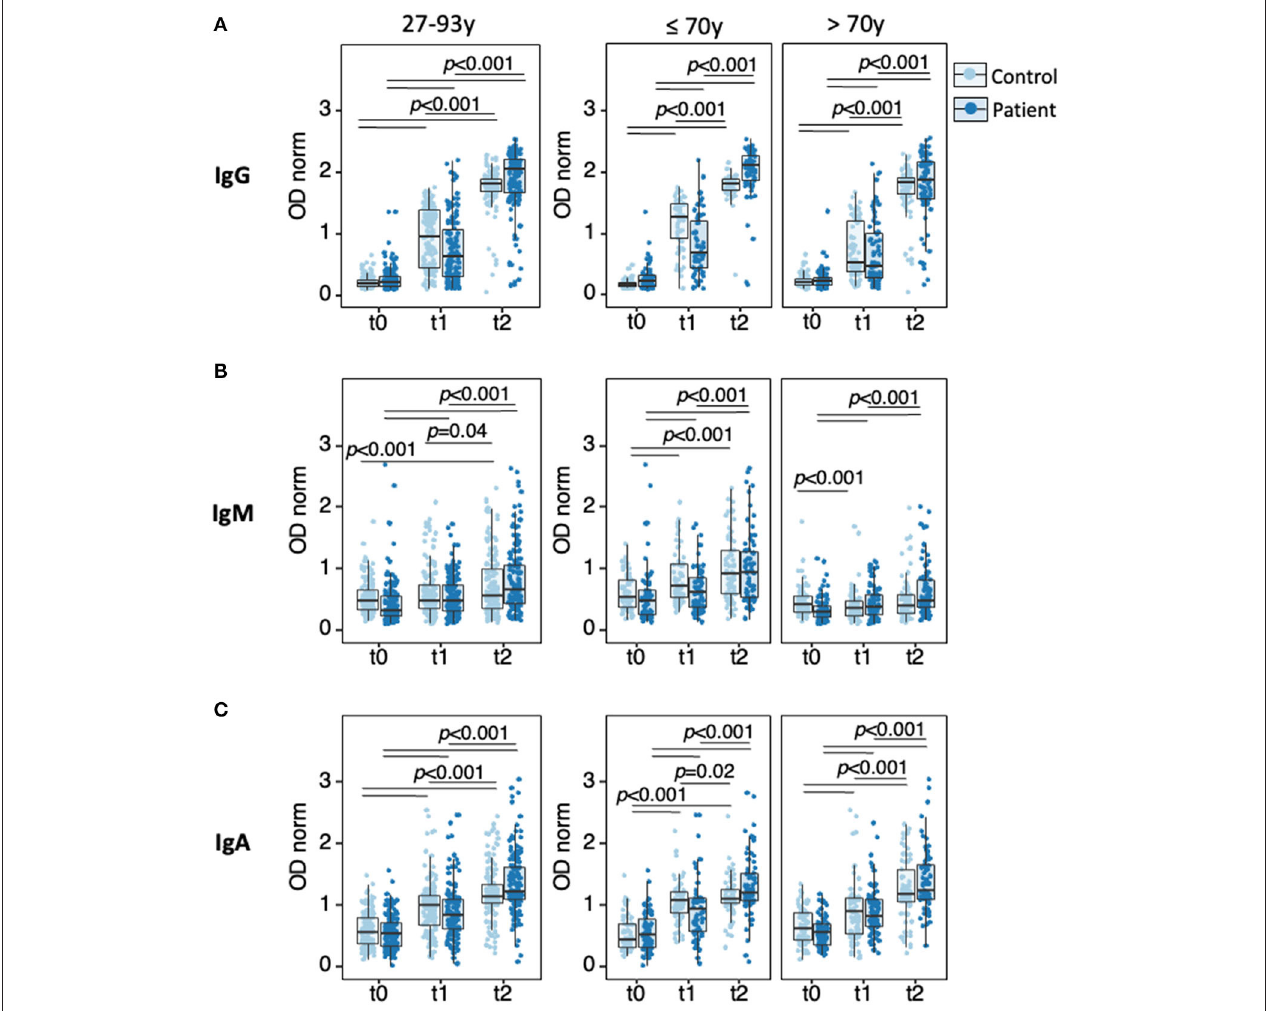
FIGURE 3 | Anti-SARS-CoV-2-spike IgG, IgM, and IgA responses to vaccination. Sera collected at t0, t1, and t2 were analyzed by ELISA for semi-quantitative measurement of anti-spike IgG (A) , IgM (B) , and IgA (C) in HD patients (dark blue, n = 143) and age-matched controls (light blue, n = 143), in the full cohort (left panels) or upon stratification by age group ( ≤ 70 y, middle panels; > 70 y, right panels). Data points represent individual subjects and are overlaid with boxes representing interquartile range (IQR), whiskers representing 1.5 IQR tails, and a central line representing median value. Differences were determined by Quade test for antibody levels along time in the full cohort (all 9 panels), Wilcoxon signed-rank test for pairwise comparison in each panel ( p- values indicated by horizontal black bars), and Wilcoxon rank-sum to compare controls with patients at t1. Detailed p- values presented in Supplementary Tables 3–7 . t0, sera collected on the day of first vaccine dose; t1, sera collected 21 days post-first vaccine dose; t2, sera collected 42 days post-first vaccine dose.